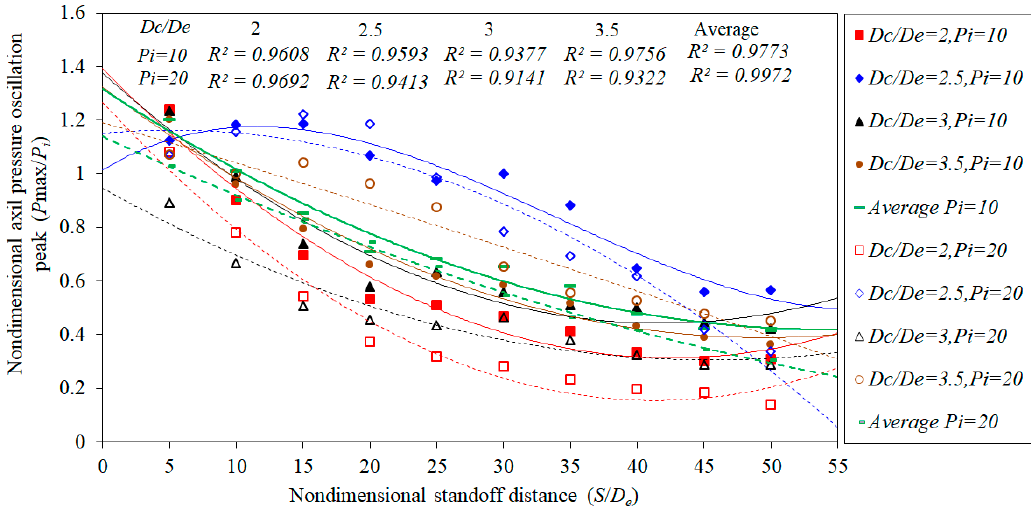
Figure 6. The dimensionless pressure oscillation peak against the dimensionless standoff distance.